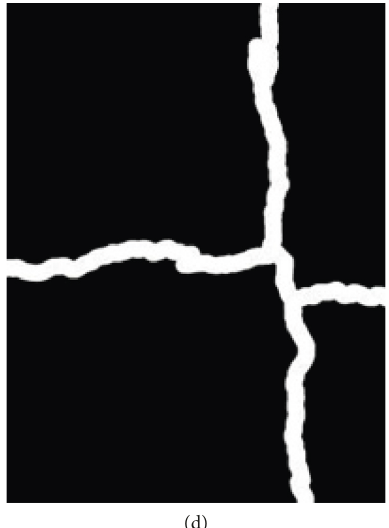
Figure 5: Image after processing. (a) Original image, (b) image after tagging, (c) ground truth, (d) bold ground truth.